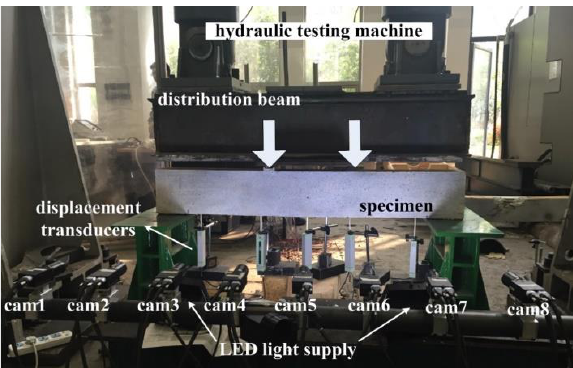
Figure 9. Experimental setup for the bending experiment of coral aggregate concrete beam.